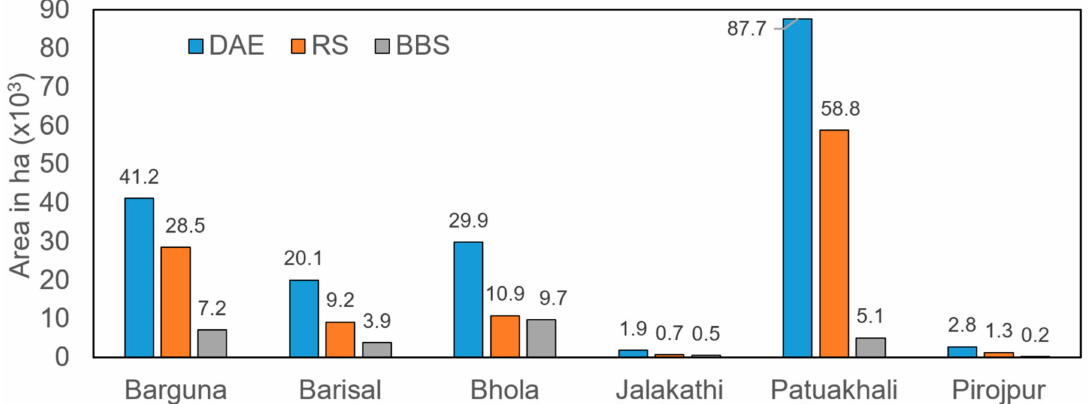
Figure 12. Area estimates for mung bean production by district in Barisal division in coastal Bangladesh during the mung bean growing season from February 6 through 17 April 2019. Data were either obtained from Bangladesh Bureau of Statistics (BBS) and the Department of Agricultural Extension (DAE) or generated with remote sensing (RS) as described in the methodology